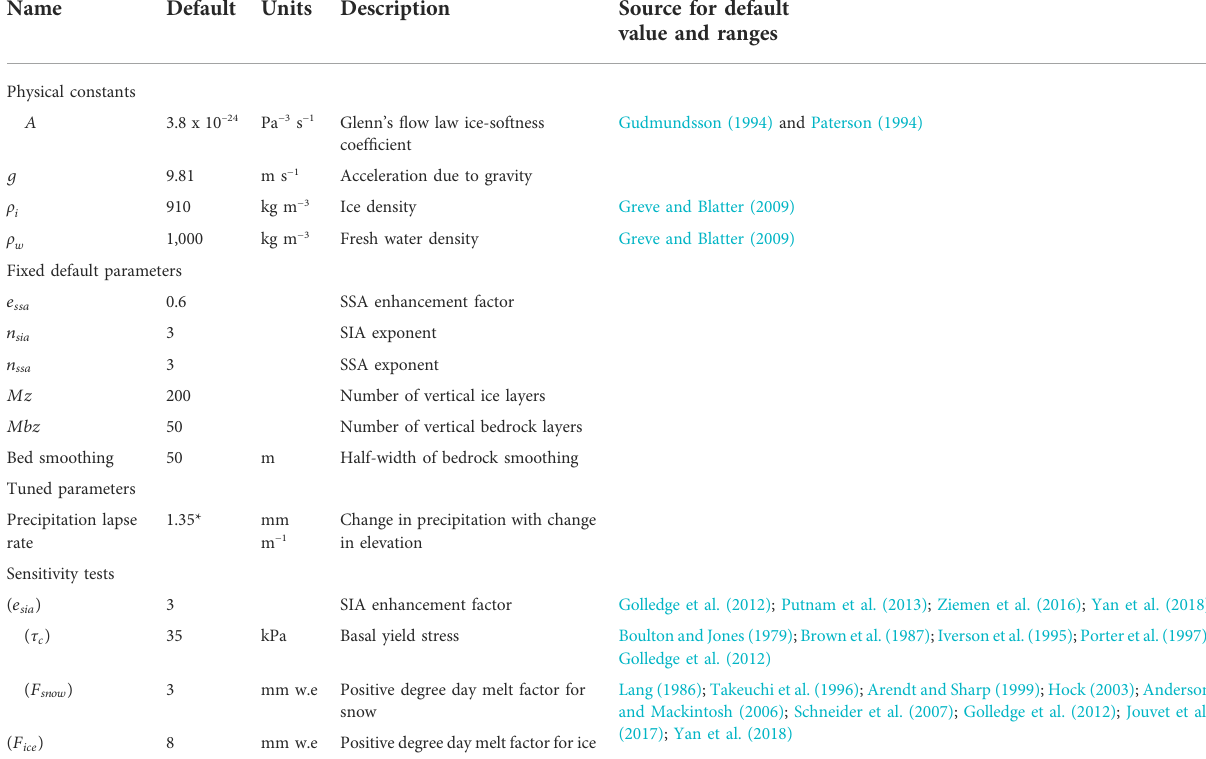
TABLE 3 Physical constants and parameter values used within the PISM model of the MSL ice cap. SIA is the Shallow Ice Approximation. SSA is the Shallow Shelf